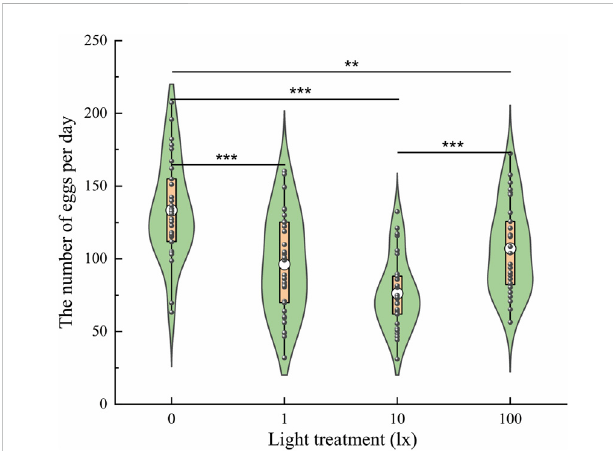
Figure 6 Number of eggs laid by ovipositing femalesthe four light intensities at night. The lower and upper vertex of lines within the violin plots, the linesoflowerandupperedgesofboxesindicate10%,90%,25%and75%, respectively; the middle circles in the box indicate the mean number of eggs laid. An asterisk (*) indicates a signi fi cant difference in the number of eggs laid among the different conditions according to Duncan ’ s post hoc test and one-way analysis of variance ( α = 0.05, *** p < 0.001, ** p <